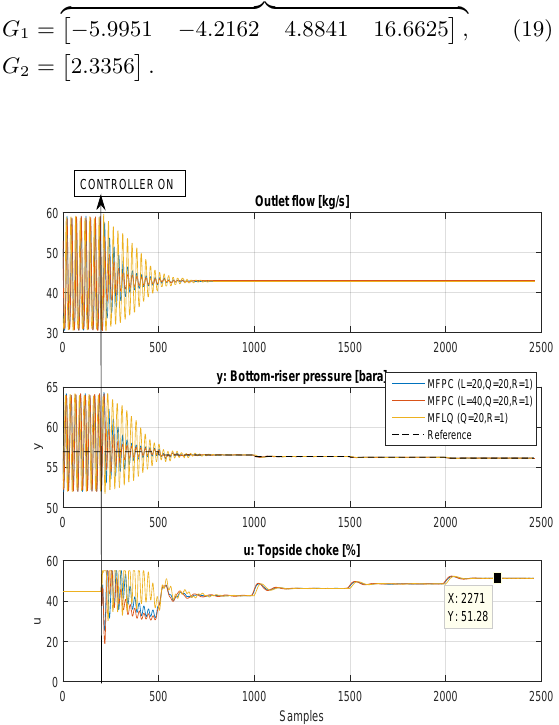
Figure 17: Implementation of MFPC and MFLQR on the K-Spice/LedaFlow simulator. Stabiliz- ing up to 51.3 % choke opening.